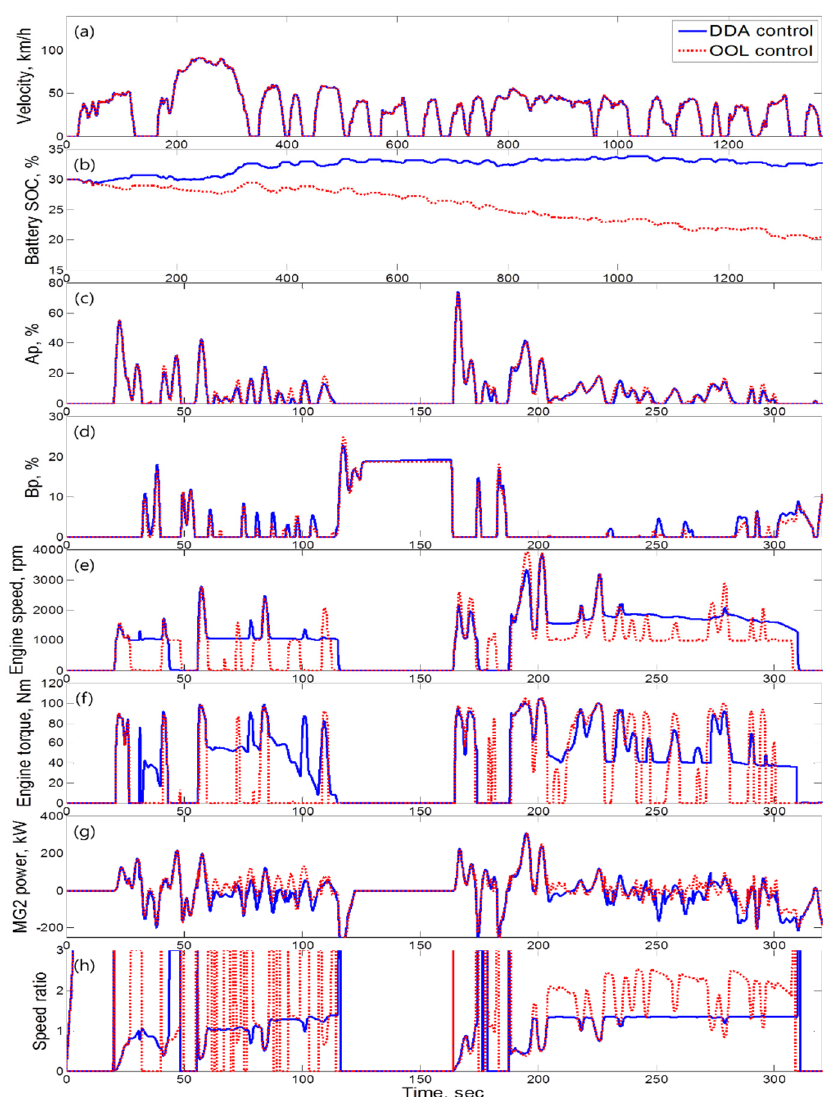
Figure 17. Simulation results of the aggressive driver (Driver 9) for the optimal operating line (OOL) control and the DDA control. ( a ) velocity; ( b ) battery SOC; ( c ) Ap; ( d ) Bp;